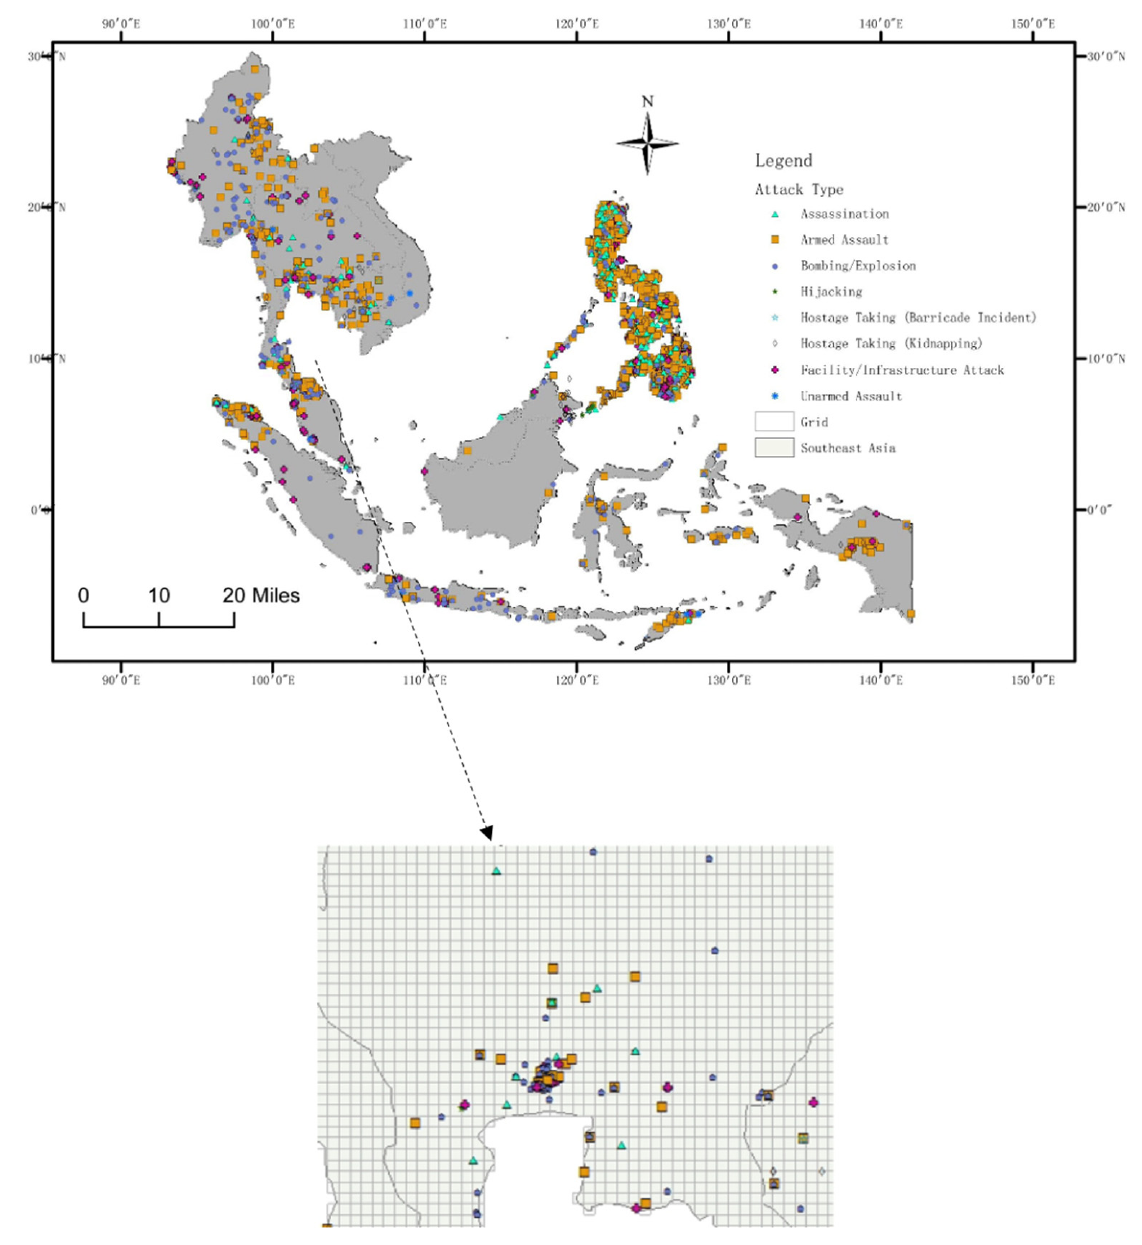
Figure 3. Gridded terrorist attacks.